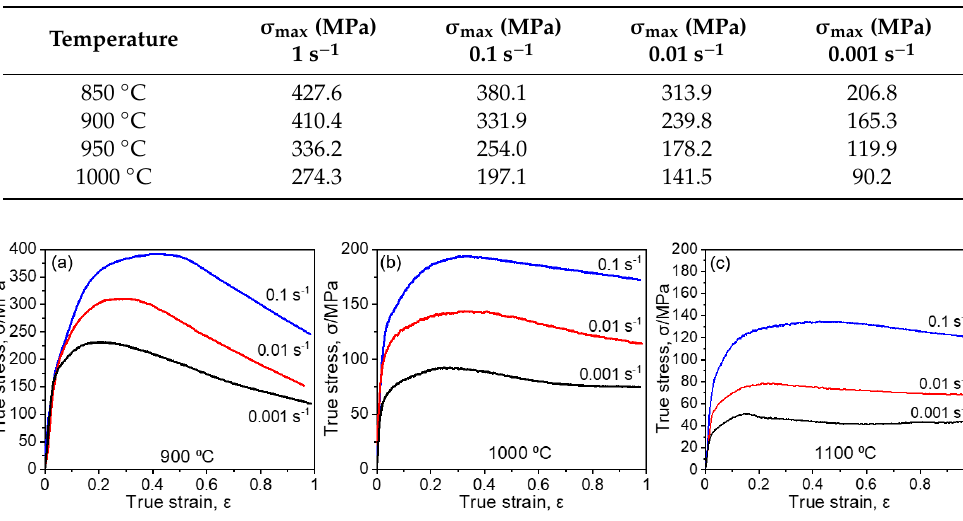
Figure 3. True stress-strain curves of the (CoCrNi) 94 Ti 3 Al 3 alloy hot-compressed at ( a ) 900 °C, ( b ) 1000 °C, and ( c ) 1100 °C. The strain rate is 0.1, 0.01, and 0.001 s − 1 . Table 2. The peak flow stress ( σ max ) of the (CoCrNi) 94 Ti 3 Al 3 alloy hot-compressed at 900, 1000 and 1100 ◦ C, respectively. The strain rate is 0.1, 0.01, and 0.001 s − 1